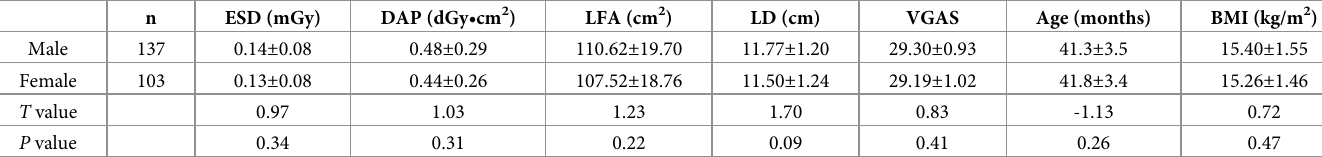
Table 3. Comparison of the demographic data, radiation dose, and image quality for participants imaged using unit A and unit B (n = 240). n Sex (m/f)